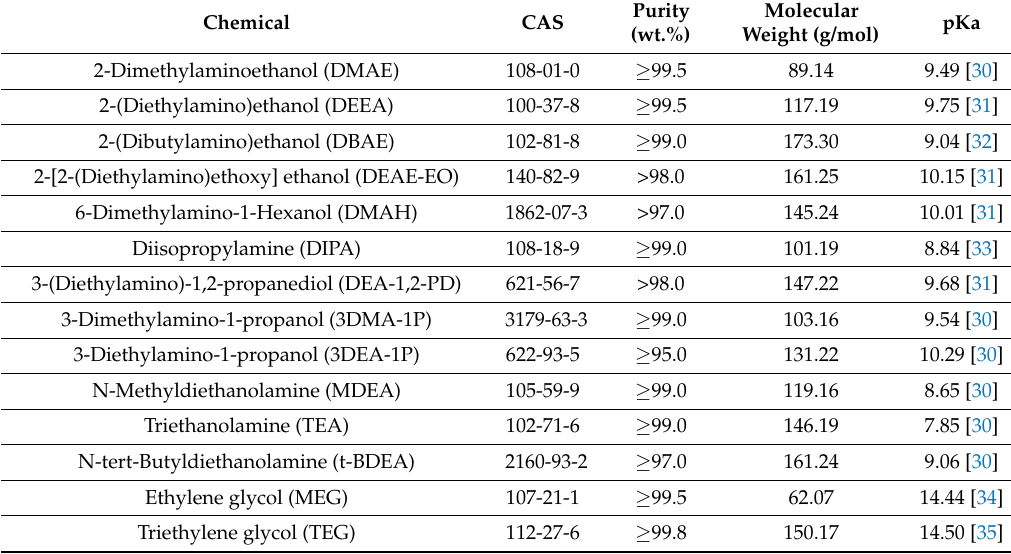
Table 1. Name, abbreviation, CAS, purity (wt.%), and pKa of chemicals. Chemical CAS